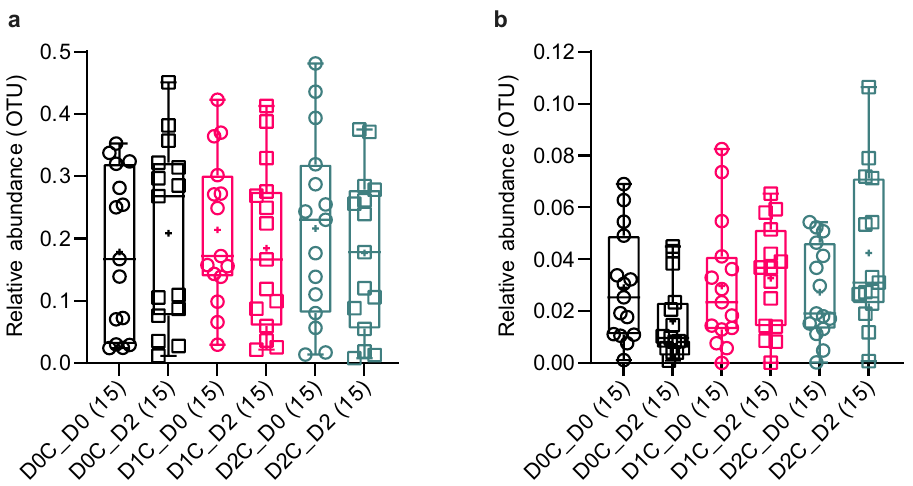
Figure 4. Relative abundance distribution of ( a ) Bacteroides and ( b ) Bifidobacterium at Day 0 and Day 2 for three doses of mixed spices intervention. No bacteria were significantly different between three different doses of spices intervention analysed by Friedman’s test with Dunn’s multiple comparison. D0C = Meal with no spices intervention, D1C = Meal with low (6 g) mixed spices intervention, D2C = Meal with high (12 g) mixed spices intervention. UG unknown genus, UF unknown family. No of samples (each intervention) was 15 and described in the parenthesis.